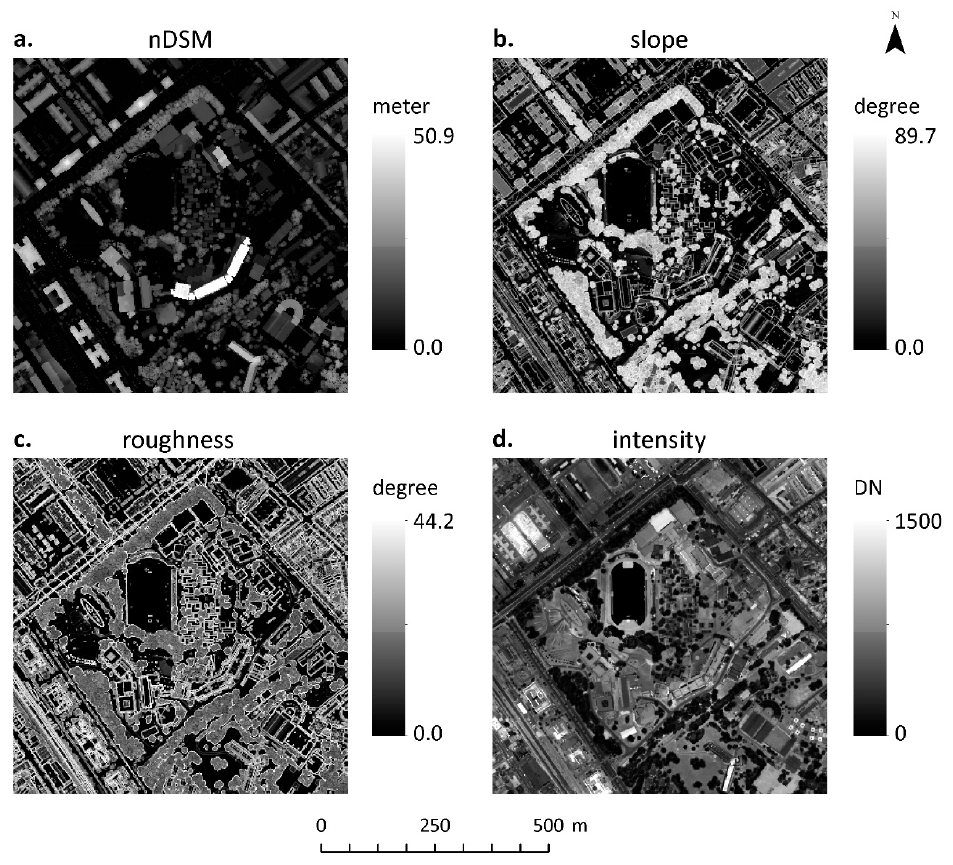
Figure 2. LiDAR features used in this research illustrated for the VUB university campus with ( a ) normalized DSM; ( b ) slope; ( c ) roughness and ( d ) intensity (expressed in uncalibrated Digital Numbers (DN)).